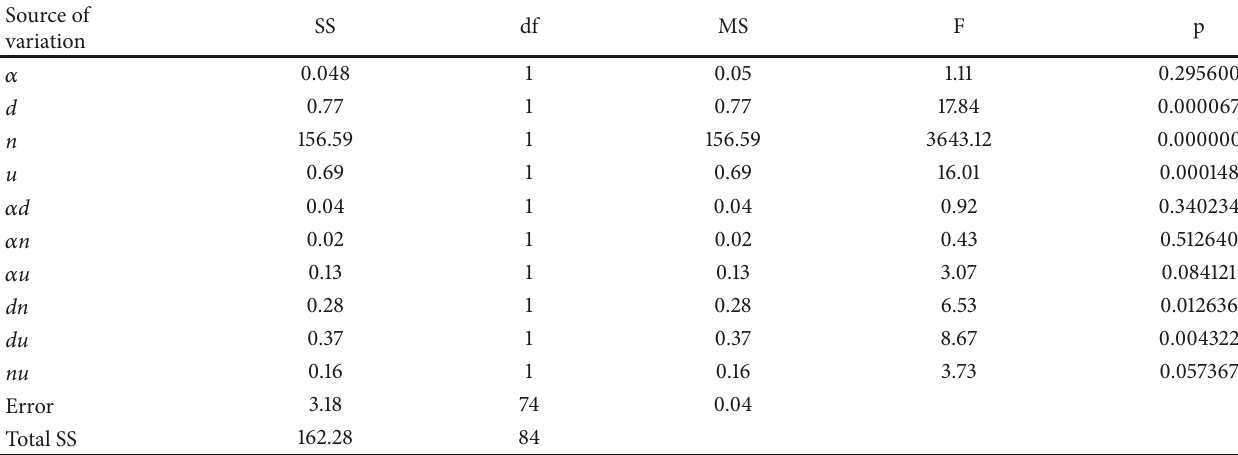
Table 4: Analysis of variance results for the modelof polymer mass flow rateG, with the coefficientof determinationand its correctedversion equal to R 2 ≈ R 2 adj =0.98. SS: sum of squares, df: number of the degrees of freedom, MS: mean sum of squares, F: values of the test statistic, p: value of probability corresponding to the test statistic value.